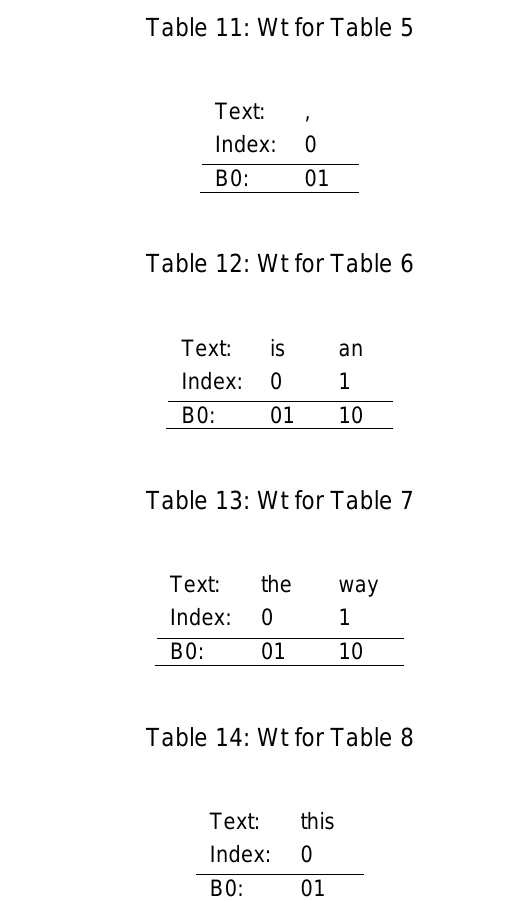
Table 11: Wt for Table 5